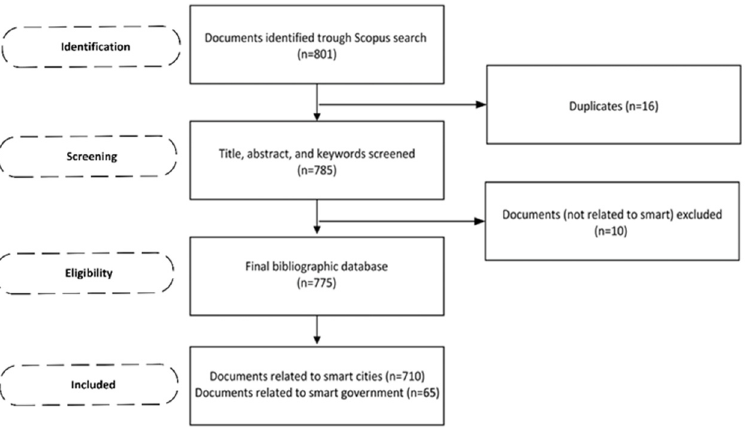
Figure 1. Flowchart of determining the Scopus search.